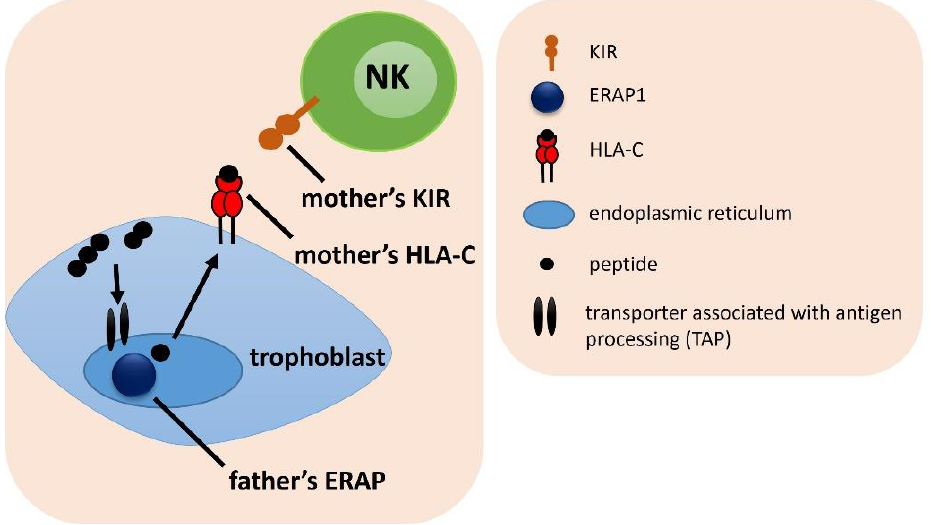
Figure 4. The influence of female KIR/HLA-C and male ERAP on embryo implantation. The arrows indicate the successive stages of the formation of antigenic peptides.